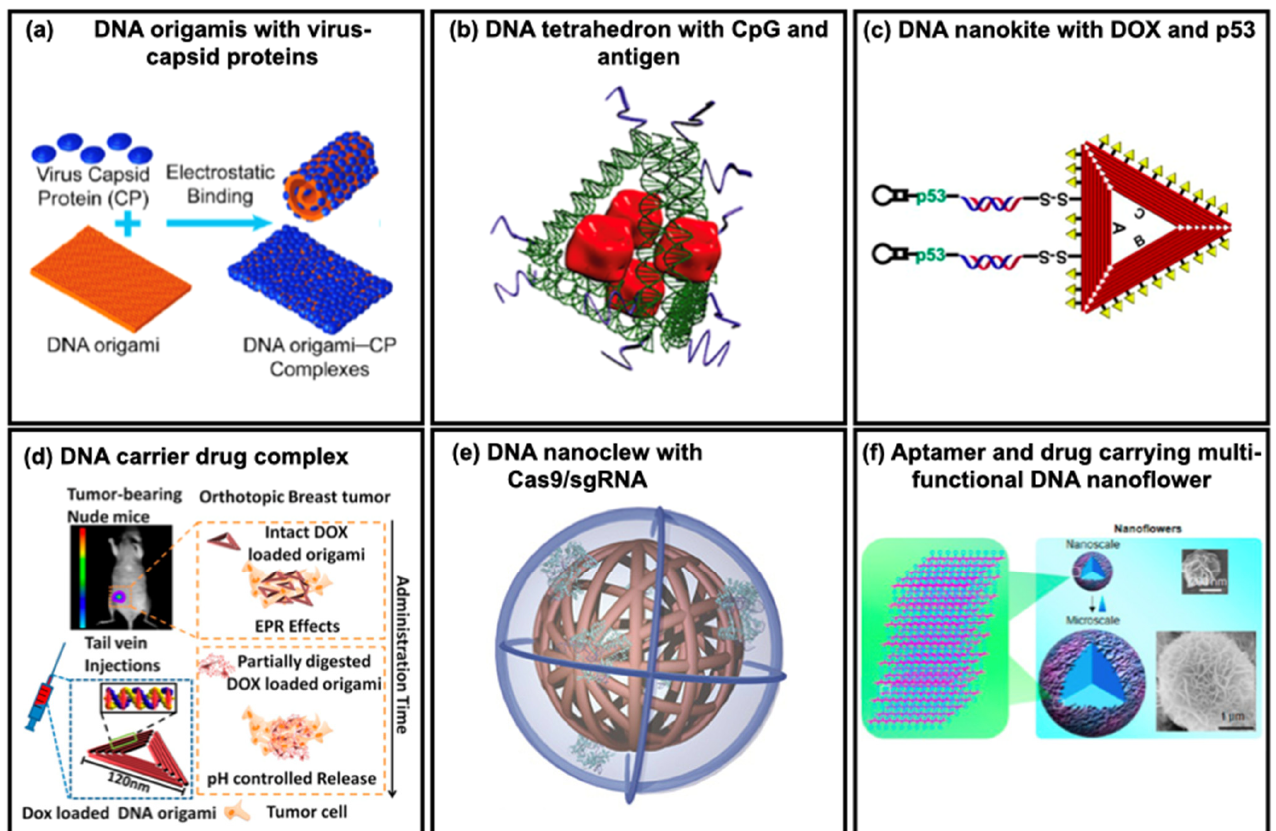
Figure 3. Drug delivery systems based on DNA nanostructures. ( a ) Self-assembly of DNA origami with virus capsid proteins (CPs) to increase transfection efficiency to the cell. Adapted with permis- sion from [28]. Copyright © 2022, American Chemical Society. ( b ) Tetrahedral DNA nanostructure with CpG and antigen as a synthetic vaccine complex. Adapted with permission from [49]. Copy- right © 2022, American Chemical Society. ( c ) A DNA nanostructure-based co-delivery system con- taining a linear tumor therapeutic gene (p53) and a chemotherapeutic drug (doxorubicin, DOX) for the combined therapy of multidrug-resistant tumors (MCF-7R). Adapted with permission from [50]. Copyright © 2022, American Chemical Society. ( d ) DOX/DNA origami complexes injected into the tail of tumor-bearing mice was delivered through blood circulation to accumulate in the breast tu- mor of mice due to enhanced permeability and retention (EPR) effects. Adapted with permission